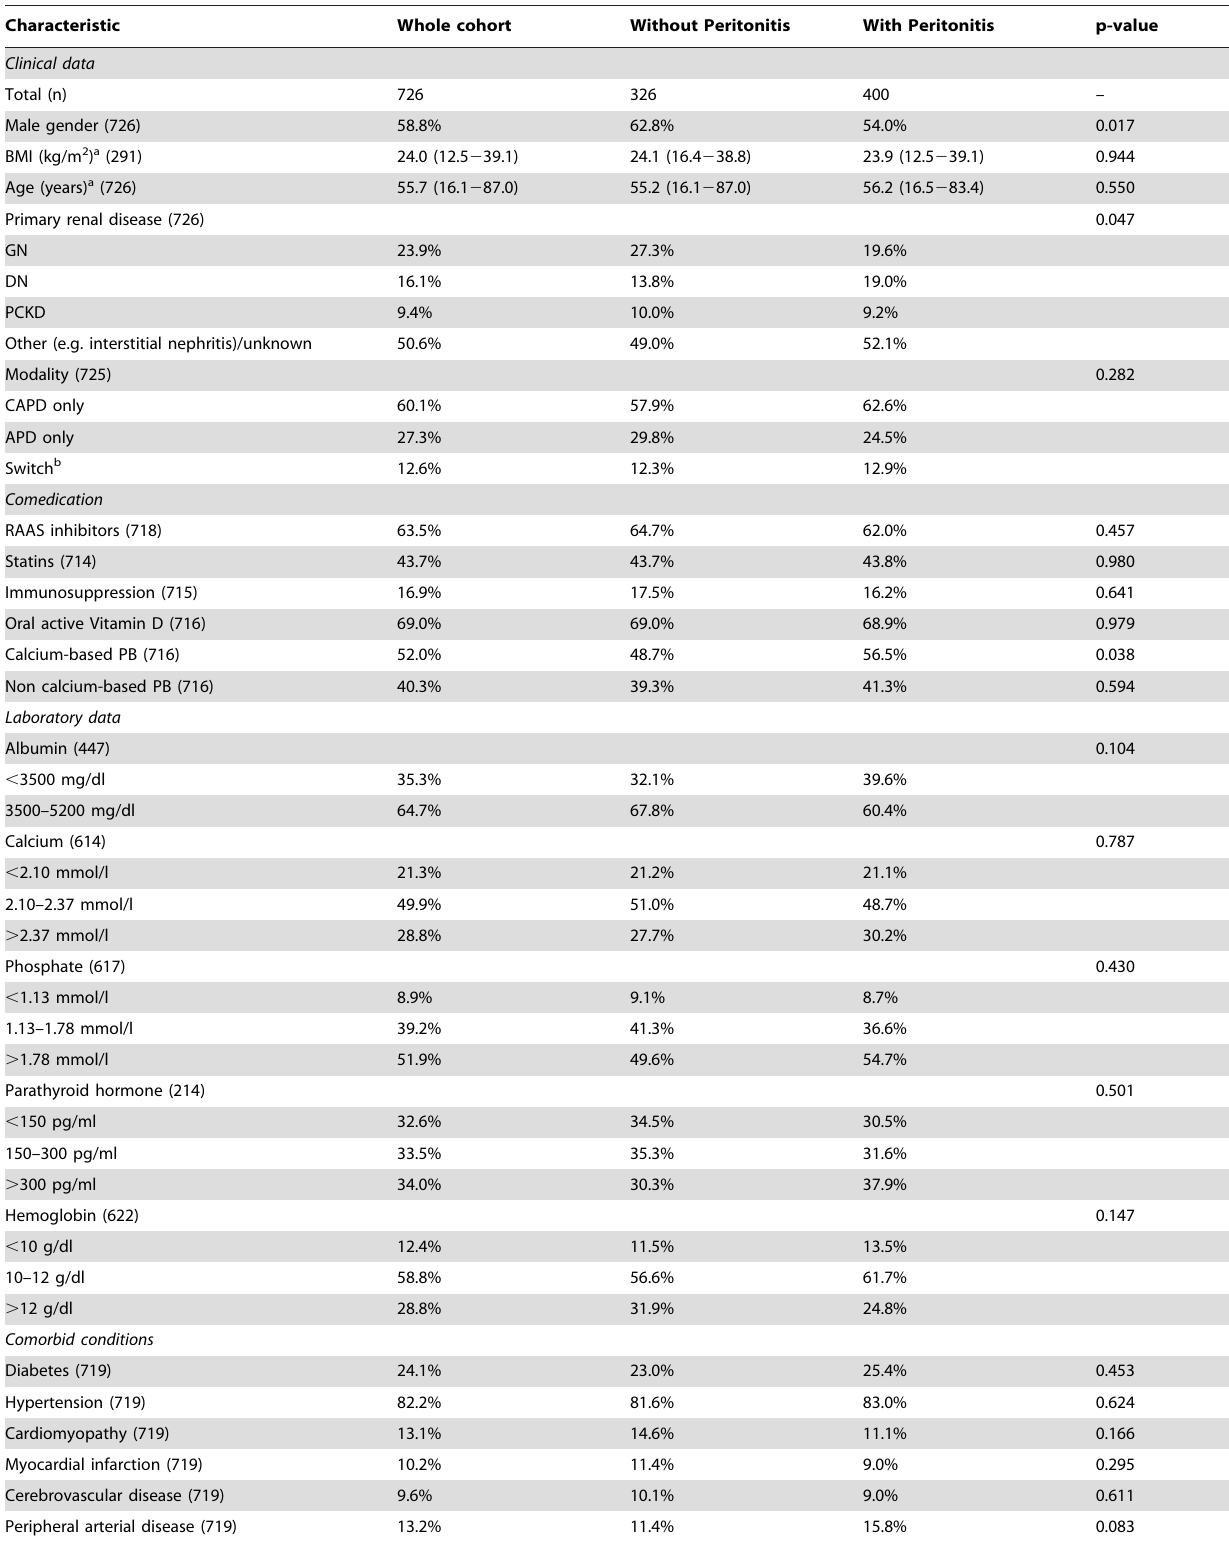
Table 1. Patient characteristics at